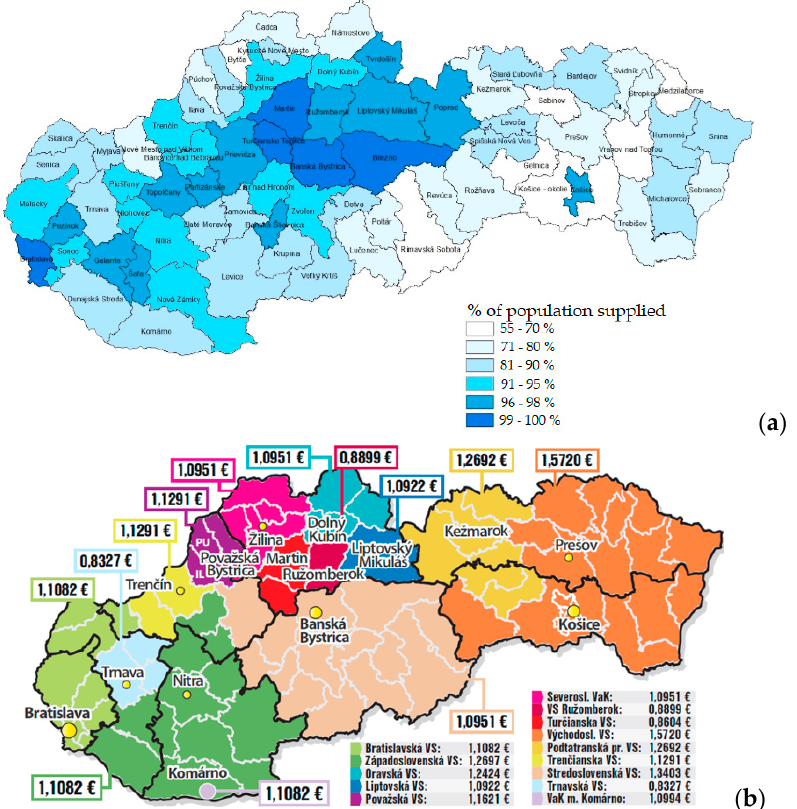
Figure 2. ( a ) Drinking water supply in 2015 ( b ) Division of Water utilities into the region